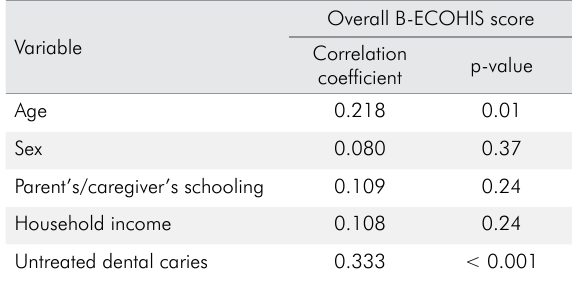
Table 3. Correlation values between the B-ECOHIS and variables.